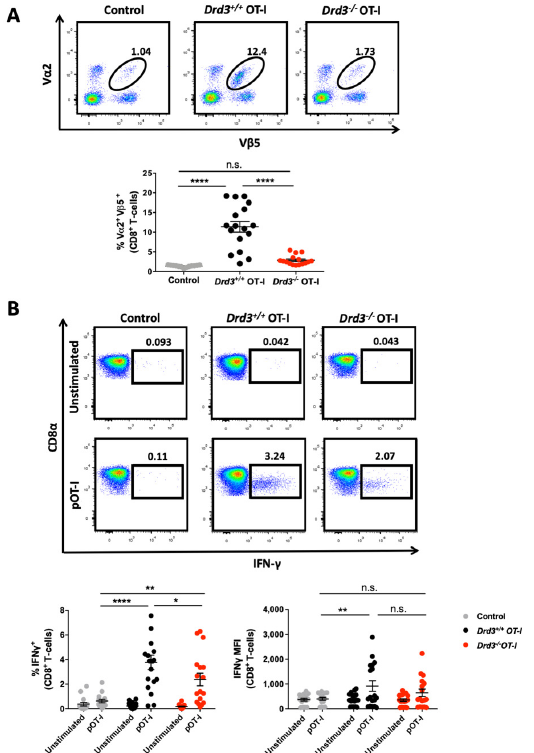
Figure 1. Drd3 -deficiency results in attenuated CD8 + T-cell expansion and reduced IFN- γ production. Splenic CD8 + T-cells were isolated from Drd3 +/+ or Drd3 − / − OT-I mice, and then i.v. transferred into male or female C57BL/6 mice (2 × 10 5 cells/mouse). A group of mice did not receive the transfer of exogenous T-cells (Control). One day later, mice received an intradermal vaccination with 40 µ g of pVAX- OVA and, 11 days after vaccination, blood samples were obtained. ( A ) The expansion of OT-I cells was evaluated as the percentage of cells expressing the transgenic TCR (V α 2 V β 5) in the CD3 + CD8 + ZAq − gate. Representative dot-plots are shown in the top panel. Numbers indicate the percentage of cells in the indicated region. Quantification is shown in the bottom panel. ( B ) Cells were left unstimulated or stimulated with pOT-I (1 µ g/mL) for 6 h, and the intracellular production of IFN γ was evaluated in the CD8 + T-cell population by flow cytometry. Representative dot-plots are shown in the top panel. Numbers indicate the percentage of cells in the indicated region. Quantification of the percentage of IFN γ + CD8 + T-cells (left bottom panel) and the mean fluorescence intensity (MFI) associated with IFN γ + in the CD8 + ZAq − gate are shown. ( A , B ) Data from three independent experiments ( n = 15–18 mice per group) is shown. Each symbol represents data from an individual mouse. The mean ± SEM are depicted. *, p < 0.05; **, p < 0.01; ****, p < 0.0001 by one-way ( A ) or two-way ( B ) ANOVA followed by Tukey’s post hoc test. n.s., not